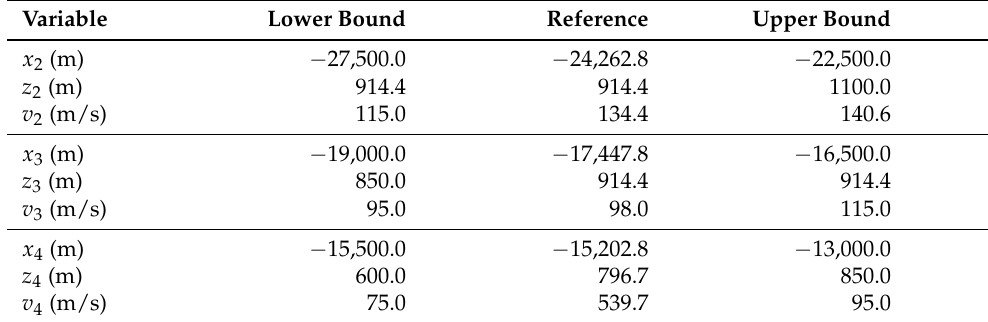
Table 5. Approach manoeuvre optimisation variables for the single-aisle aircraft: reference values with upper and lower bounds.